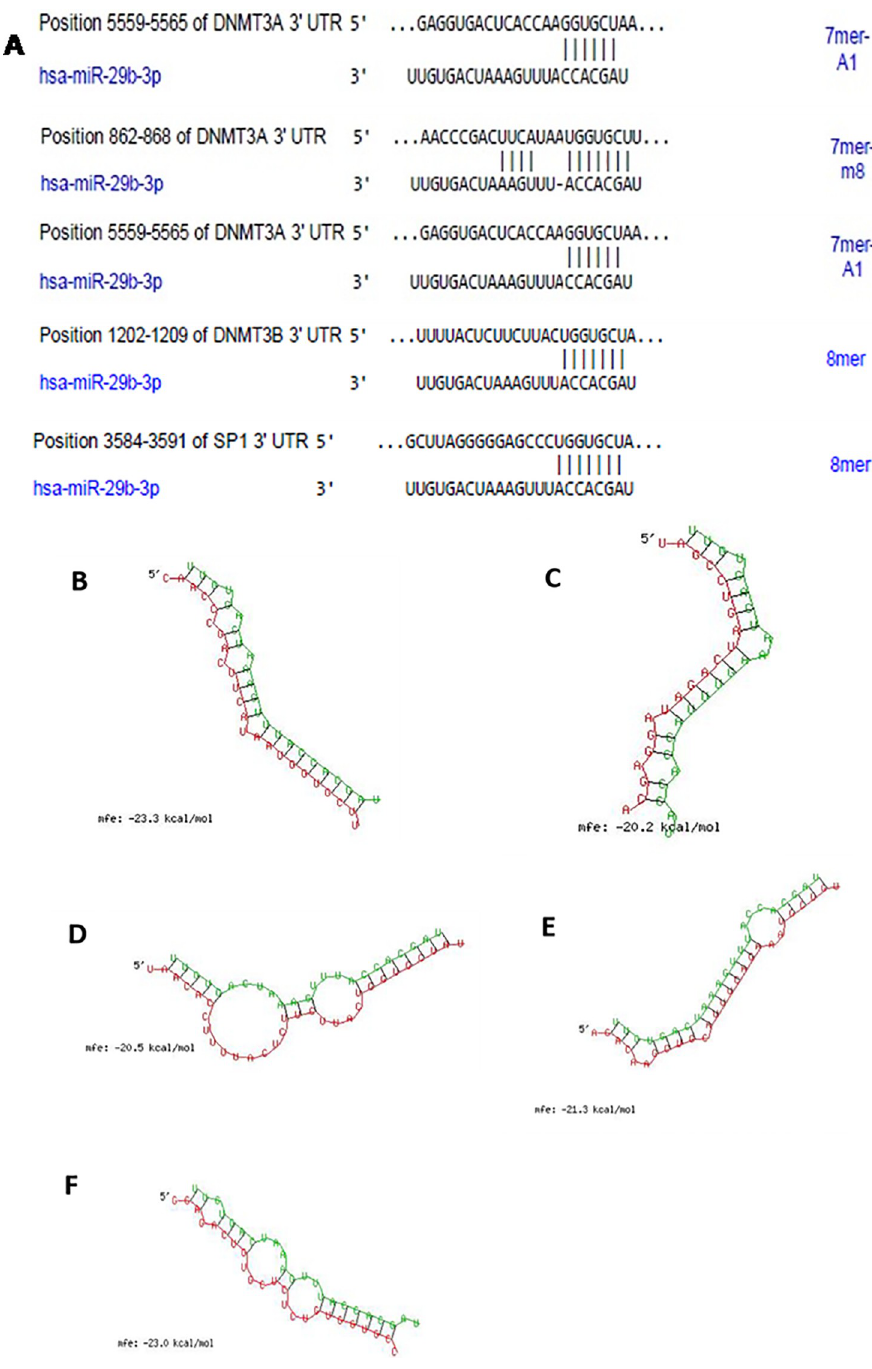
Fig 1. Bioinformatics analysis of miR29b prediction via TargetScan and RNAhybrid tool. A: Binding position prediction of 3’UTRs of DNMT3A, DNMT3B and SP1 with miR29b by TargetScan. B and C: Secondary structure prediction of DNMT3A mRNA with miR29b by RNAhybrid. D and E: Secondary structure prediction of DNMT3B mRNA with miR29b by RNAhybrid. F: Secondary structure prediction of SP1 mRNA with miR29b by RNAhybrid.